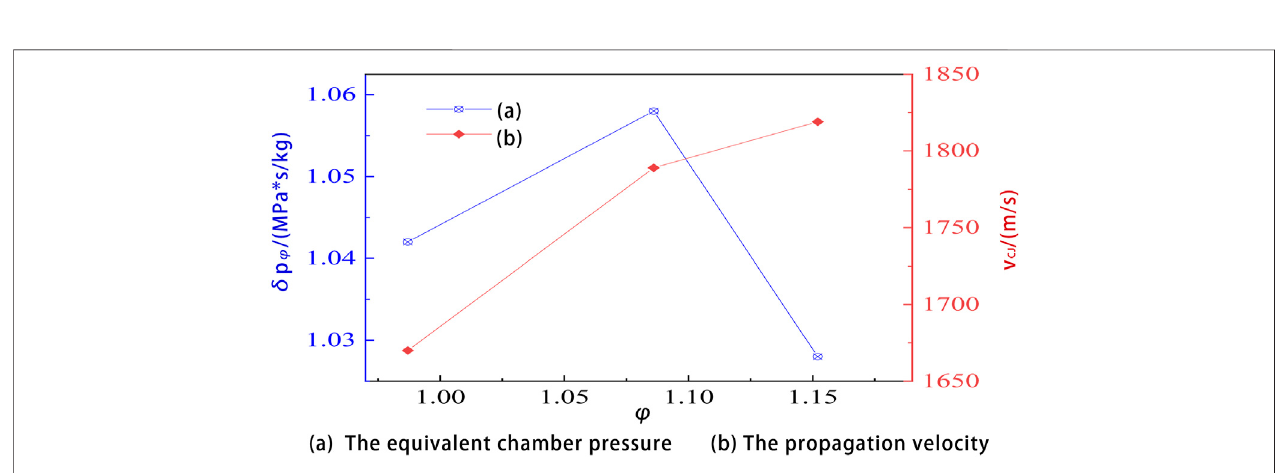
FIGURE 17 | Performance of the RDC with the equivalent ratio. (A) The equivalent chamber pressure; (B) The propagation velocity.